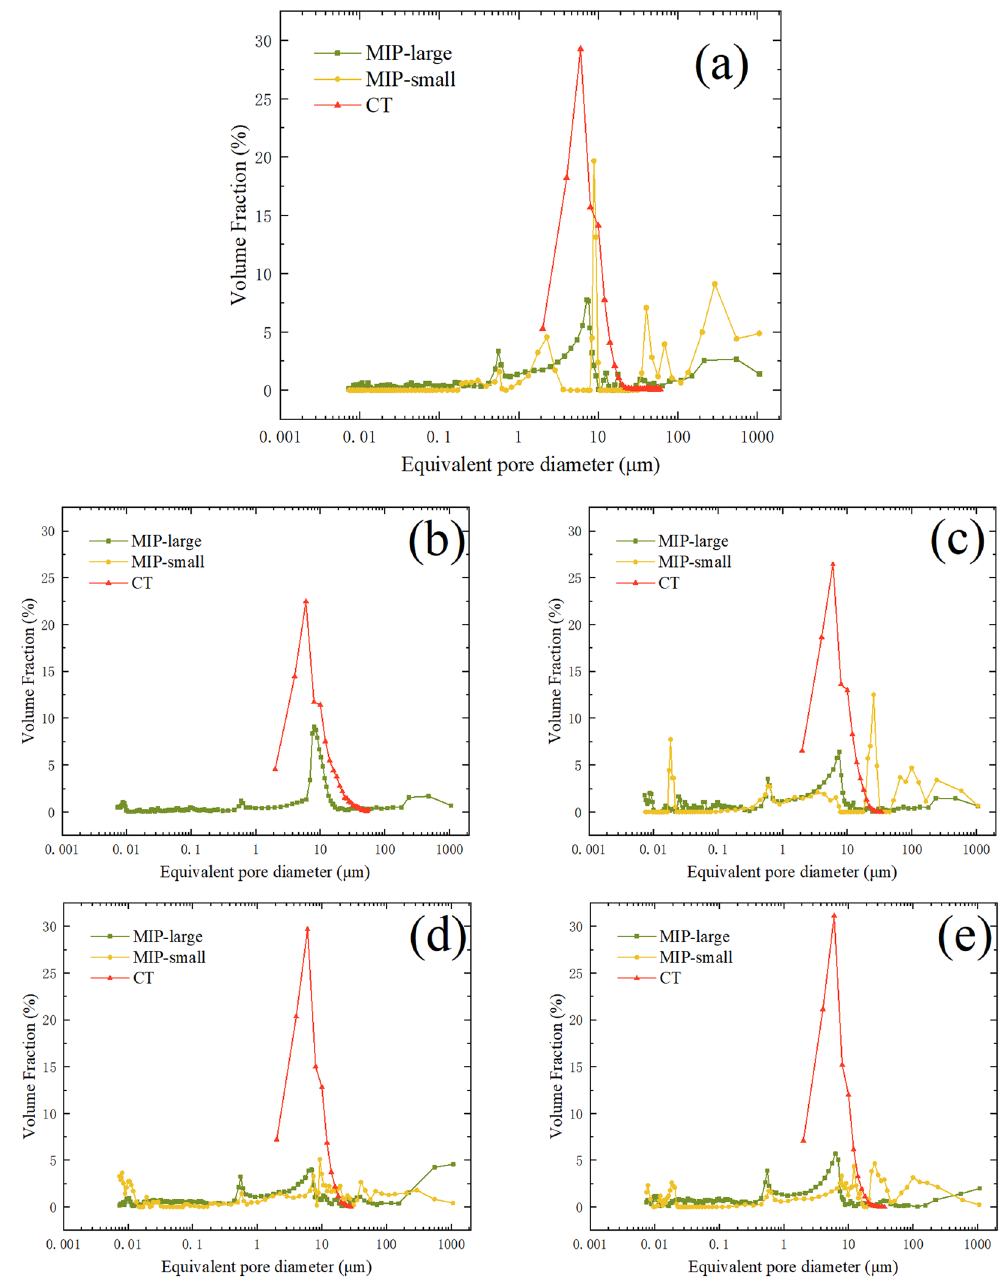
Figure 2. PSDs of the samples obtained from different tests: (a) YA-L6-Intact; (b) YA-L6-1.5; (c) YA-L6-1.6; (d) YA-L6-1.7; (e)